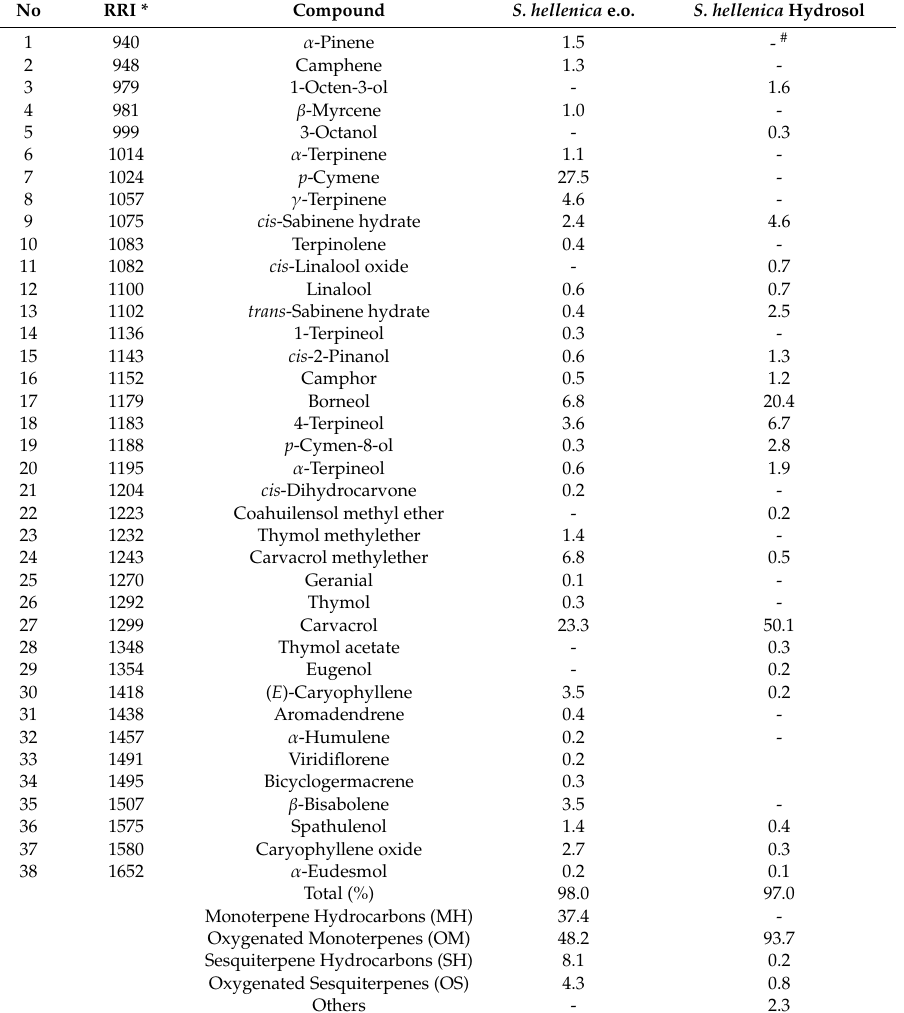
Table 1. Chemical composition of the essential oil and hydrosol of Satureja hellenica .